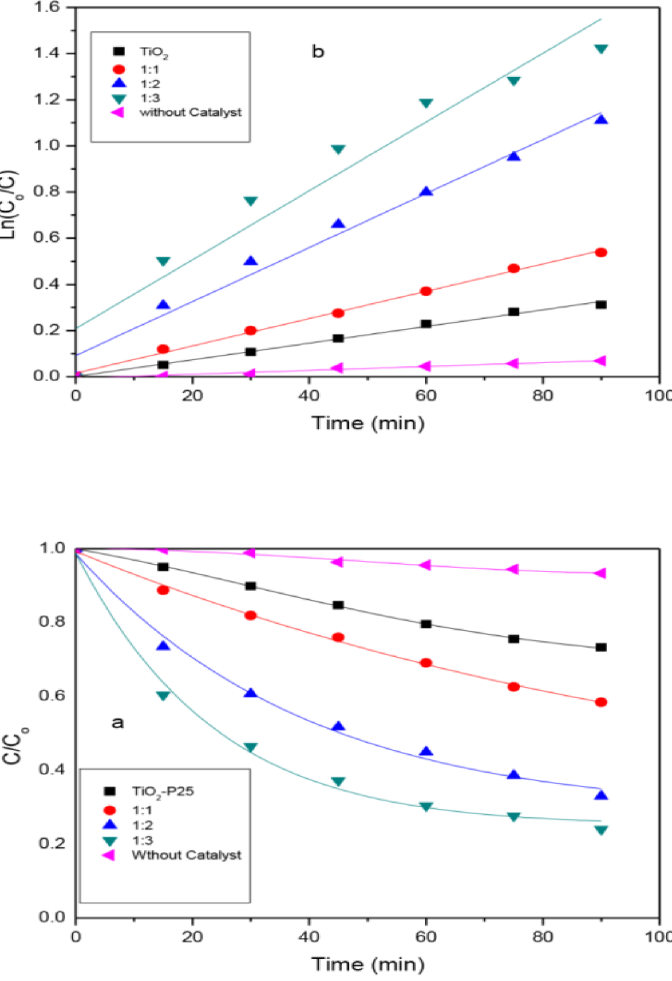
Fig 6. A normalised concentration ( C / C 0 ); C 0 initial concentration at t = 0 , C concentration at time t versus reaction time ( t ) for different samples tested(a); and the kinetic plots of apparent first-order linear transform ln ( C o /C ) against time of irradiation (t) (b). doi:10.1371/journal.pone.0125511.g006 Fig 8 shows the MB photodegradation versus time. The figure shows a higher degradation rate at alkaline and neutral mediums. 50% degradation of the MB was observed at half-life = 20.8 and 29.3 min for the pH at 10.2 and 7.0, respectively. However, in the acidic environment, only 45% of the MB was degraded for 90 min. This may be attributed to the amphoteric nature photocatalyst, where it reacted as an acid or base. The TiO of the TiO 2